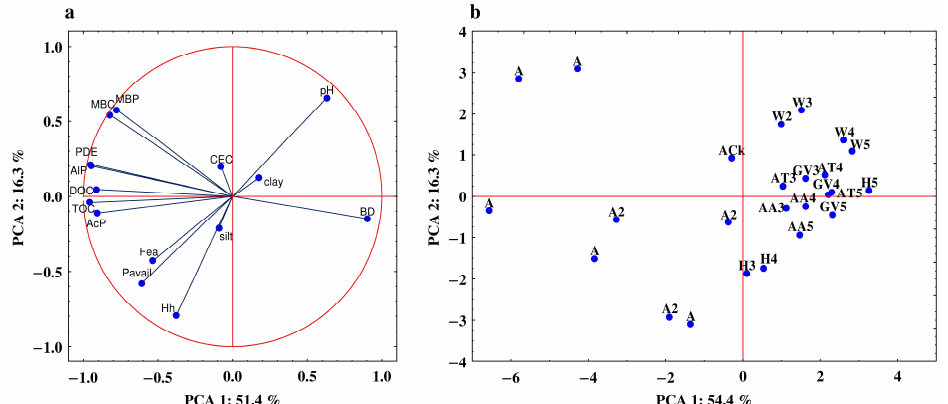
Figure 7. PCA analysis obtained from the studied soil variables: ( a ) plot of the PC1 and PC2 for the